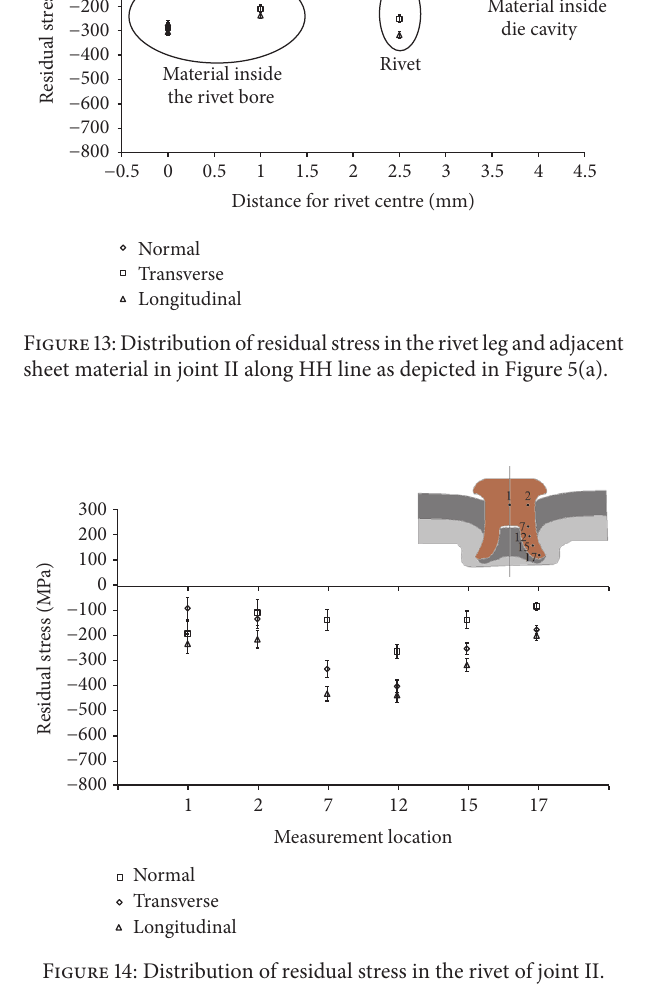
the top and bottom sheets. Therefore, the material inside the gauge volume was a mixture of